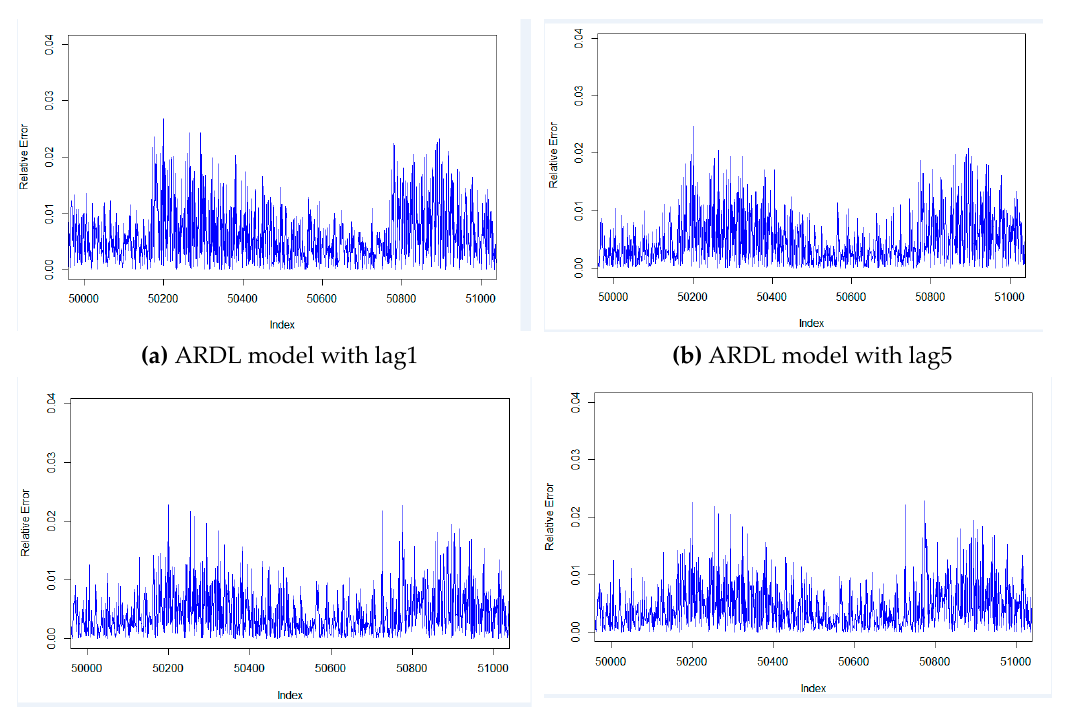
Figure 5. Actual error of ARDL model for predicting the HPTET temperature. Figure 5 contains eight graphs, which were listed as follows: ( a ) ARDL model with lag 1, ( b ) ARDL model with lag 5, ( c ) ARDL model with lag 10, ( d ) ARDL model with lag 15, ( e ) LR model, ( f ) NN model, ( g ) SR model, ( h ) DNN model.